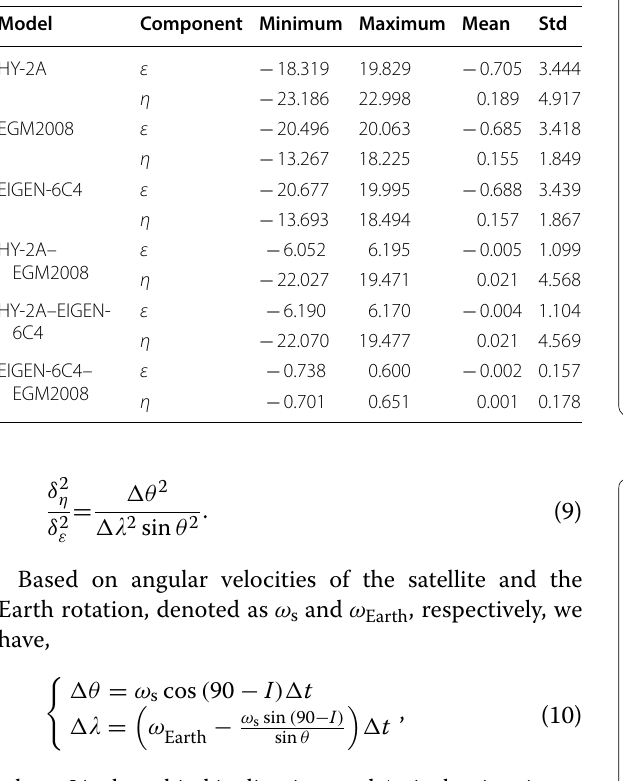
Fig. 8 Initial gravity anomaly derived from